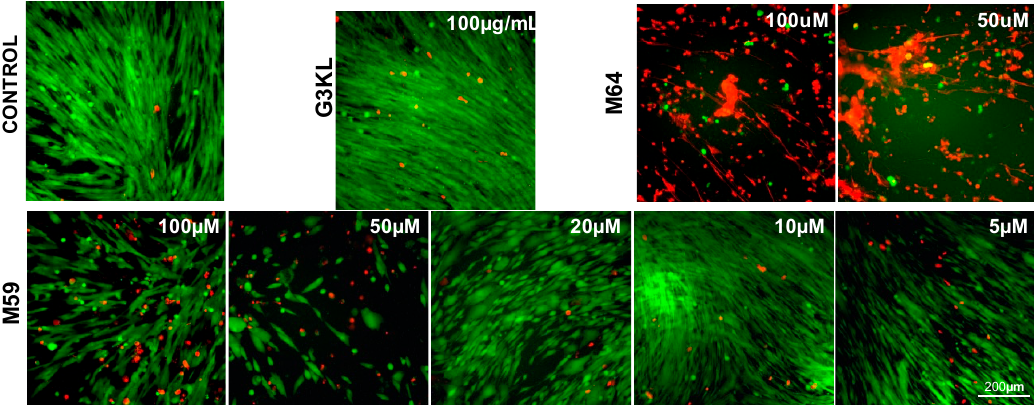
Figure 4. Assessment of the viability and morphology (Live/Dead assay) of human progenitor fibroblast cells incubated with different antimicrobial compounds. Cells were cultured for 24 h in the presence of G3KL or QS-inhibitors (M64 and M59). Higher concentration M64 and M59 induced death and morphological changes in cells. M59 did not induce cell death or morphology changes at concentrations below 20 µM. Live cells are stained green and dead cells are stained red.